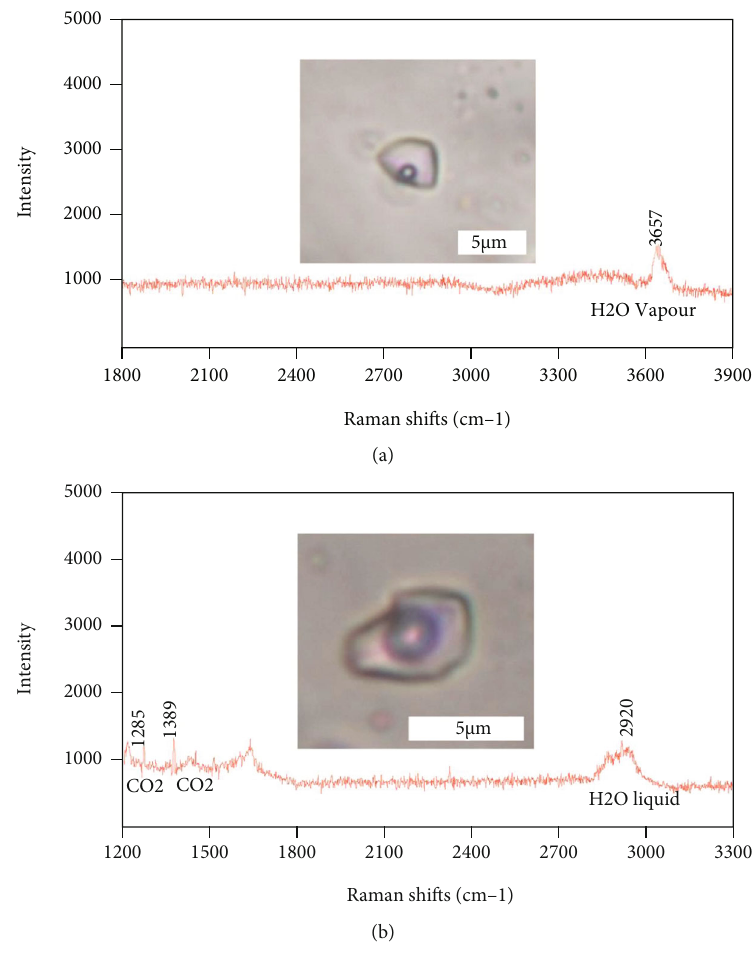
Figure 8: Microstructures and laser Raman spectra for fl uid inclusions in Daping gold Table 8: Microthermometric data of fl uid inclusions of the metallogenic period in the Daping gold deposit. Stage